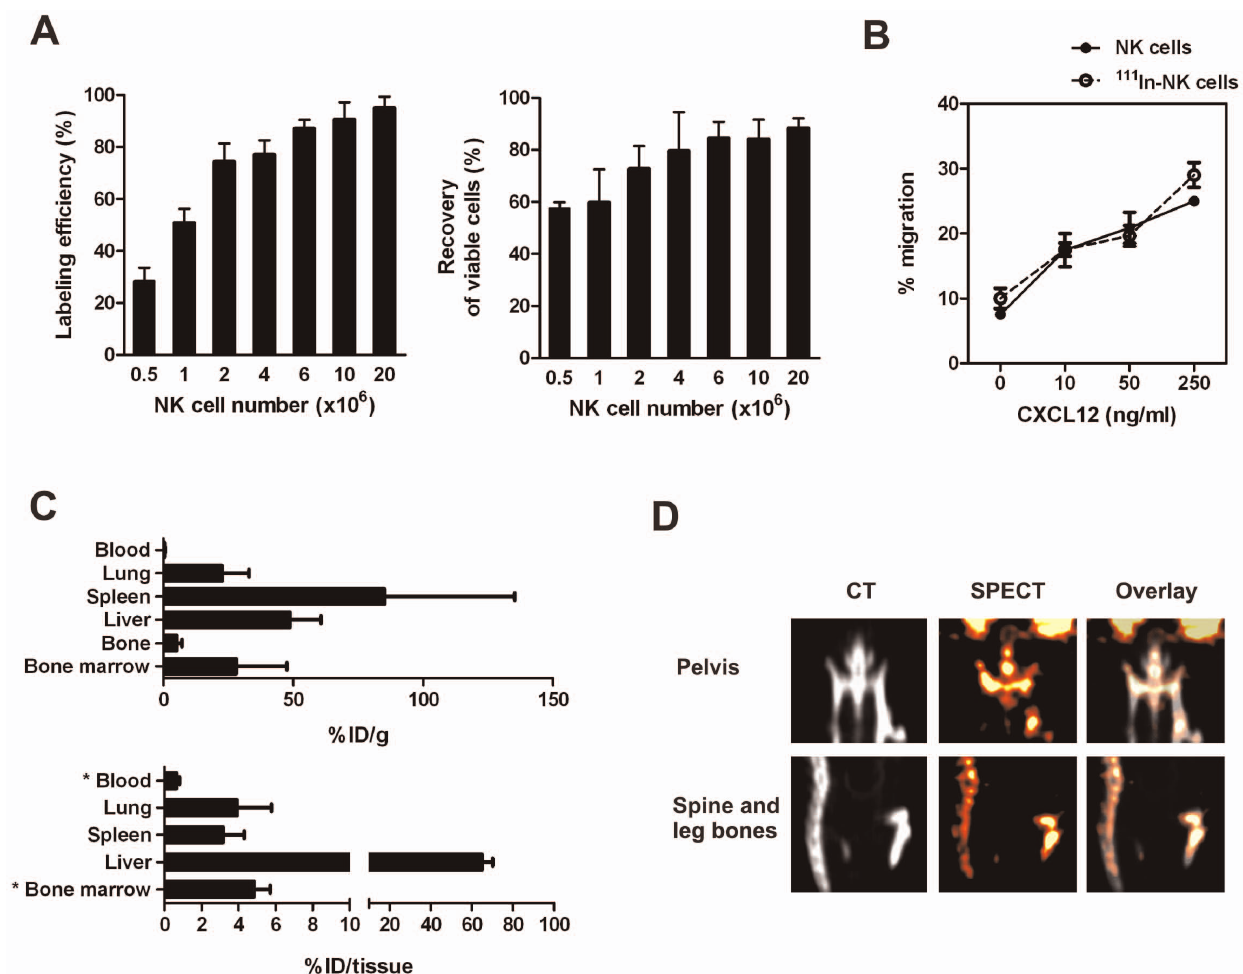
Figure 4. Organ-distribution of UCB-NK cells following adoptive transfer. (A) For optimization of NK cell labelling procedure, increasing number of UCB-NK cells were incubated with 2MBq 111 In. Graphs show mean 6 SD of three experiments performed each with a different UCB donor. Good labelling efficiency and cell recovery were achieved using . 4 6 10 6 cells per 2 MBq. Subsequently (panels B-D), 0.4MBq 111 In was added per 10 6 UCB-NK cells to label. (B) The capacity of 111 In-NK cells to migrate in response to the chemokine CXCL12 was evaluated in vitro and compared to that of unlabeled UCB-NK cells. The same experimental procedure was employed to assess the transwell migration of unlabeled and 111 In-NK cells as described in materials and methods, except that the proportion of 111 In-labeled cells present in bottom chambers were quantified using a shielded 3- inch-well-type gamma counter (Wizard; Pharmacia LKB). (C) Biodistribution analysis of 111 In-NK cells 24 h after i.v. infusion, expressed as a percentage of injected activity per gram of tissue of interest or per organ. Combined results from two experiments expressed as mean 6 SD (n=6) are shown. *Extrapolated values according to physiological parameters. (D) Representative 2D-reconstruction analysis of SPECT-CT illustrating the accumulation of 111 In-NK cells (orange) in bones